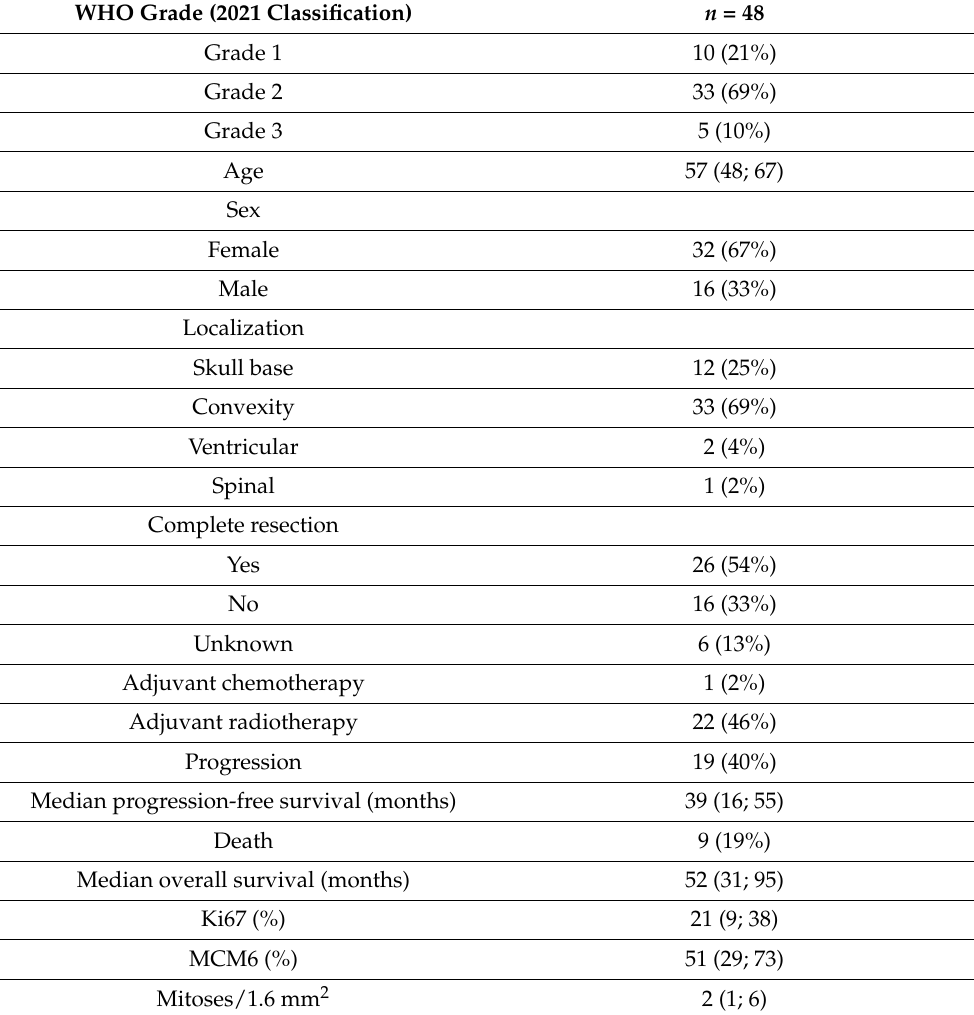
Table 1. Clinical and pathological